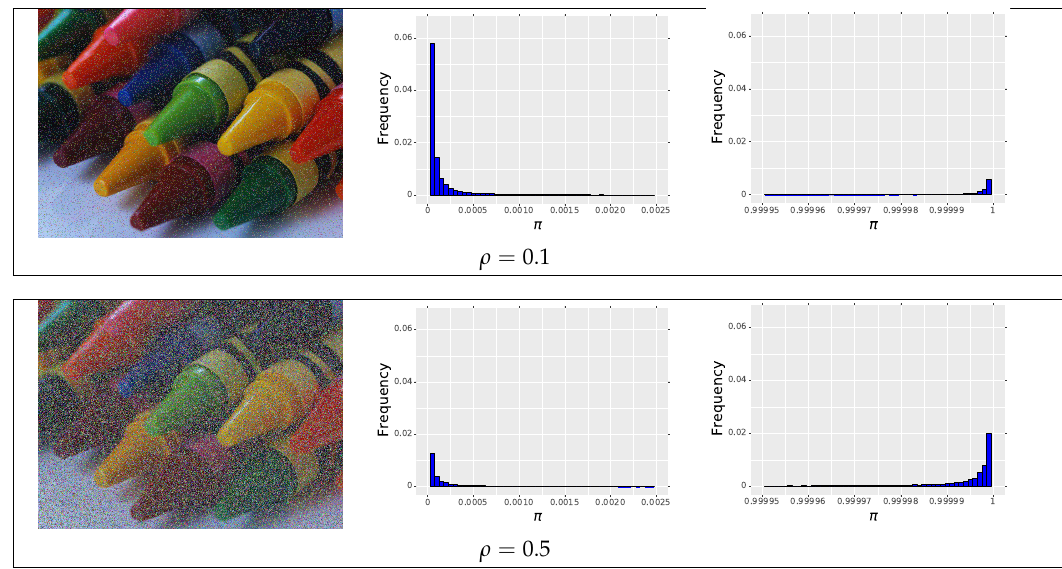
Figure 5. Exemplary distributions of the IDCNN outputs for the test image contaminated with impulsive noise with intensity ρ = 0.1 and 0.5. For the contamination ρ = 0.1, 89.59% of pixels are assigned π < 0.1 and 10.14% reaches a value π > 0.9. For noise intensity ρ = 0.5, the respective frequencies are 50.20% and 49.44%.